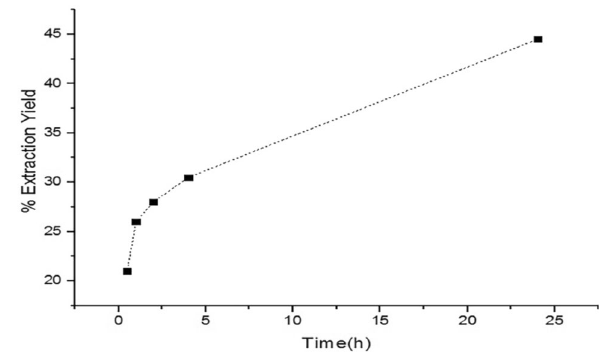
Fig. 1 A plot of extraction yield (%) versus time to optimize the extraction time of Kedla